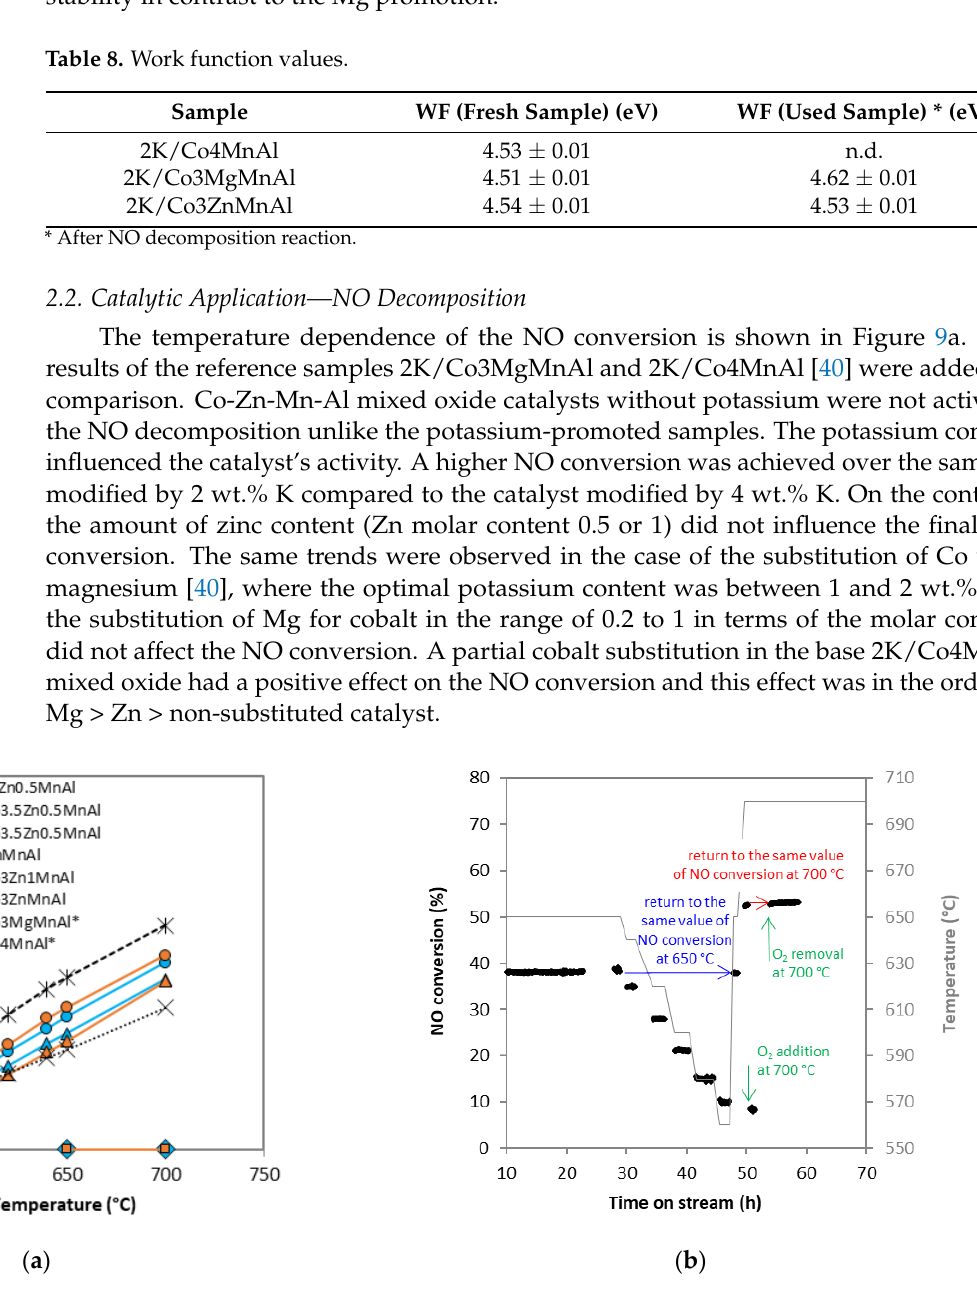
Figure 9. Dependence of NO conversion on ( a ) temperature over potassium-promoted mixed oxide catalysts; ( b ) time on stream over 2K/Co3ZnMnAl mixed oxide. Conditions: 0.1 mol.% NO or 0.1 mol.% NO and 2 mol.% O 2 in N 2 , WHSV = 6 l g − 1 h − 1 , * reference sample [40].